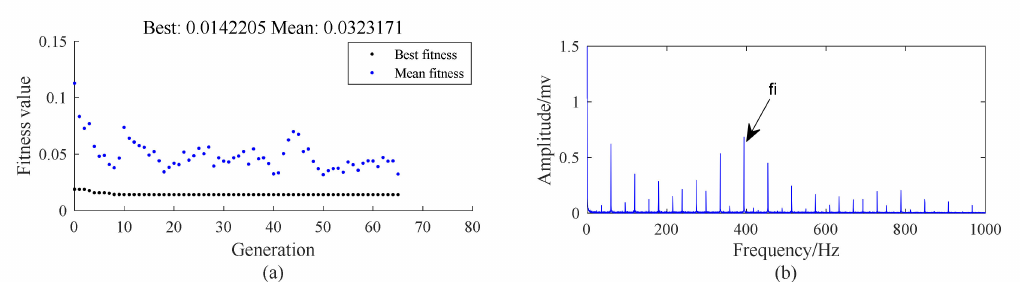
Figure 35. The diagnosis result of the collected signal of bearing with 1 mm inner race fault processed by the Optimal Wavelet Packet Transform (OWPT): ( a ) the training performance of the OWPT; ( b ) the squared envelope spectrum